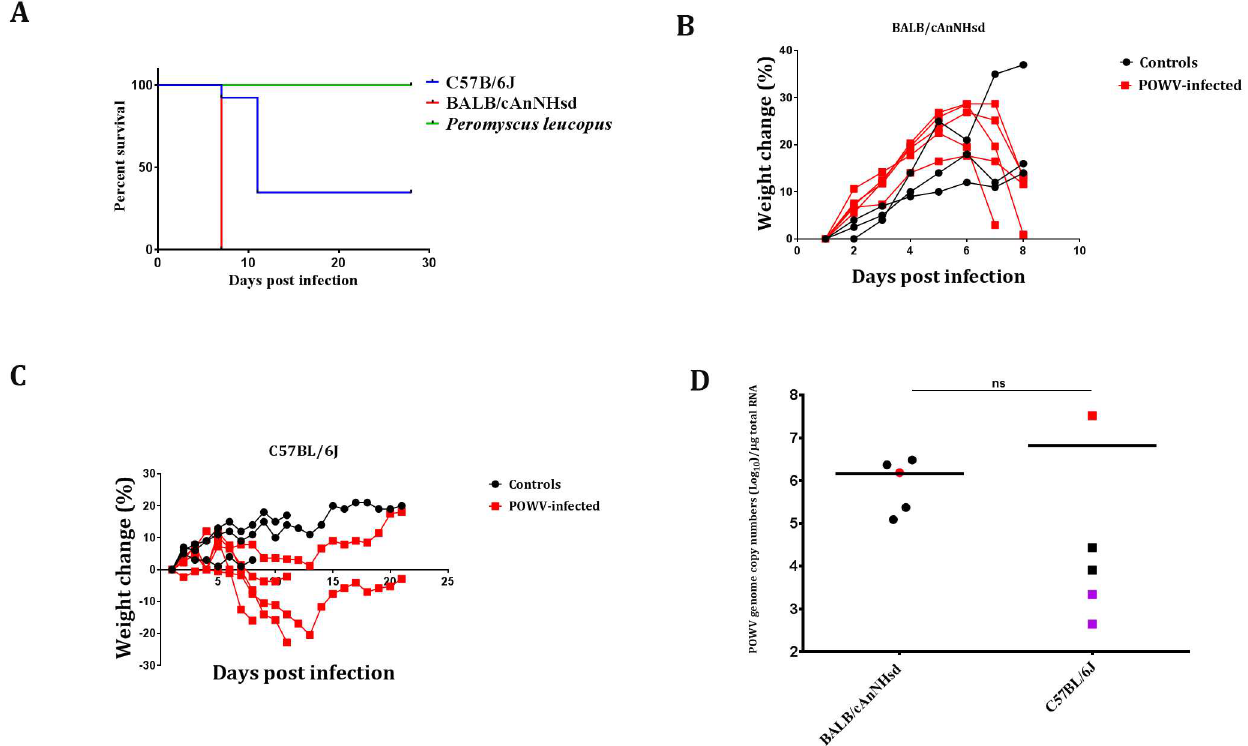
Fig 3. Analysis of i.p. inoculation of POWV in BALB/c and C57BL/6 mice. (A) Survival curve for i.p. inoculatedBALB/c, C57BL/6and P. leucopusmice. (B) Changesin weights of BALB/c mice after i.p. inoculation of POWV. (C) Changesin weights of BALB/c mice after ip inoculationof POWV. (D) POWV (+)RNA copy numbersin brains of i.p.-inoculated BALB/c and C57BL/6mice. The red dot for BALB/c mice denotes RNA copy numbers from the mouse which succumbedfirst. The red square for C57BL/6mice denotesthe mouse that succumbed at 8 dpi, the black squares represent the mice that succumbed at 11 dpi and the survivors are denotedby the purplesquares. ns: not significant(t- test).